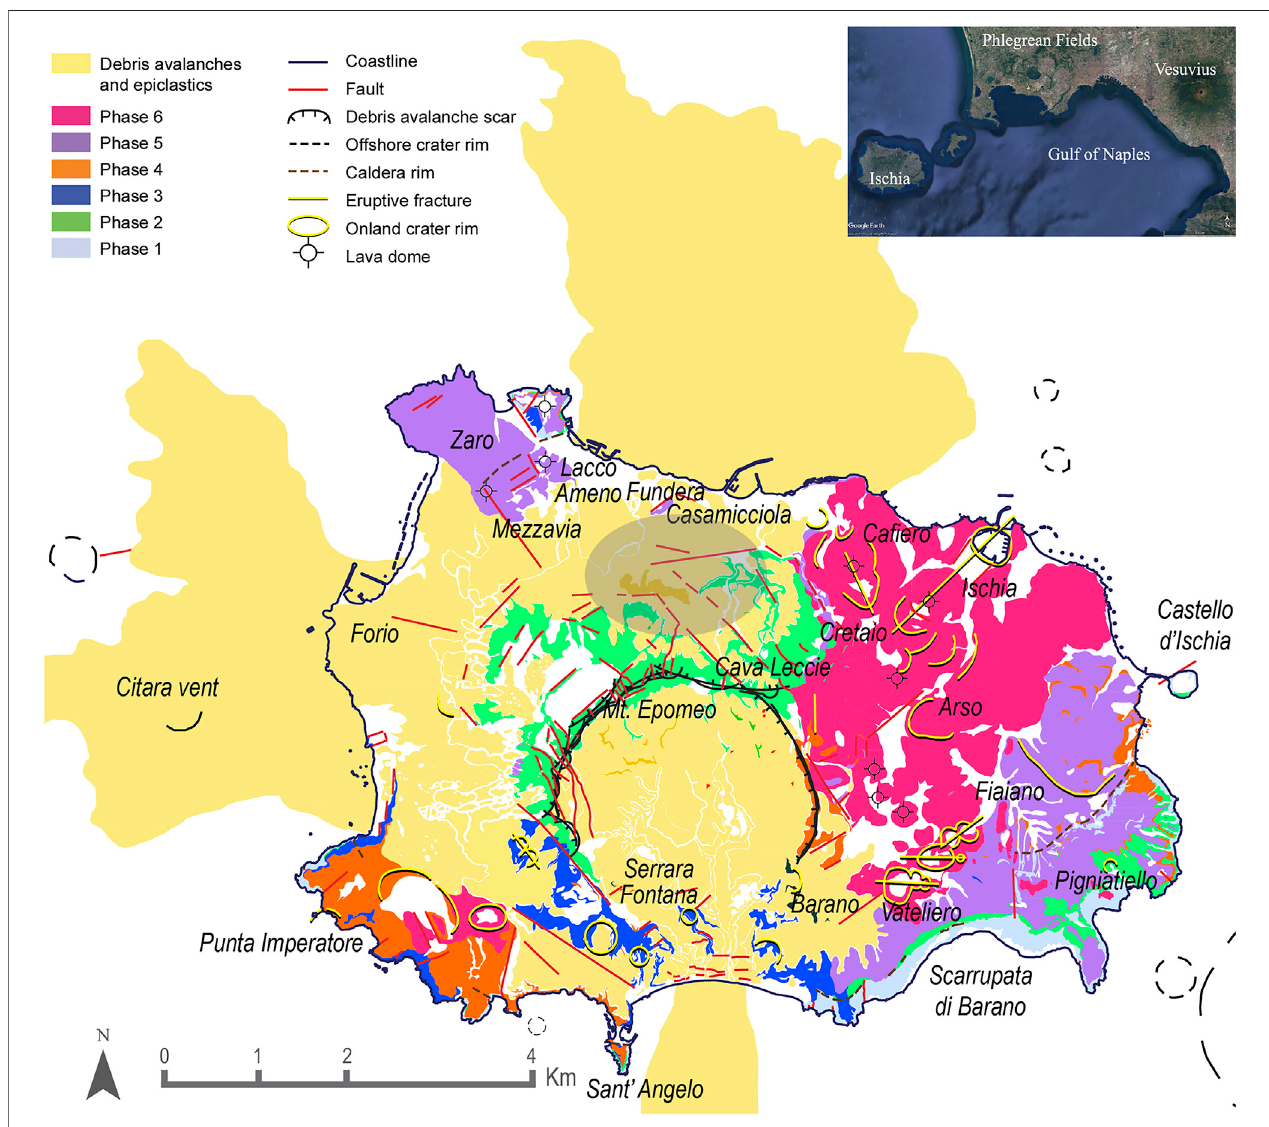
FIGURE1| VolcanologicalphasesofIschiavolcanic fi eld(Sbranaet al.,2018,modi fi ed).Thegrayshaded areaisthezone affectedbyhighestdamageofhistorical and recent earthquakes in the island.